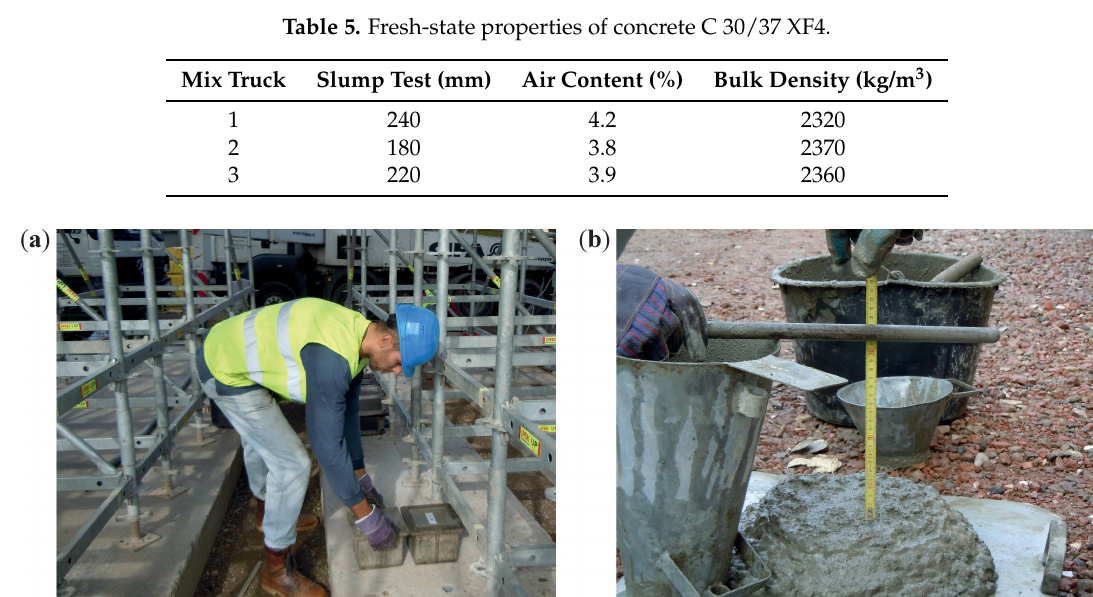
Figure 2. ( a ) cube specimens being made; ( b ) consistency